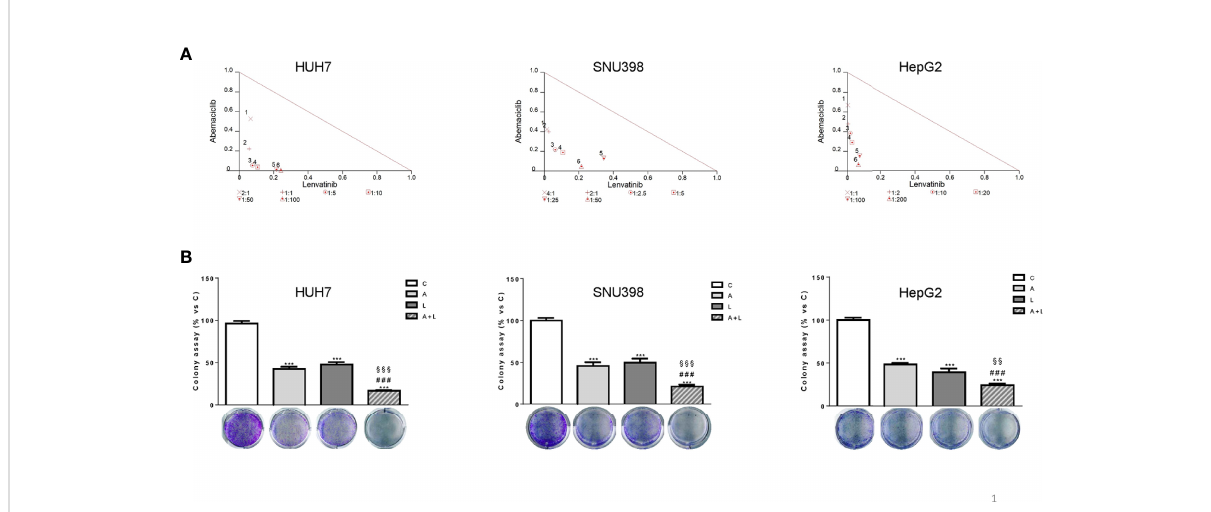
FIGURE 2 Abemaciclib and lenvatinib combination exerts additive anti-proliferative effects in HCC cells and inhibits colony formation more strongly than single agents. (A) Cells were treated with A, L or the combination. The growth medium with drugs was refreshed every 3 days. After 6 days, cell proliferation was assessed by CV assay. Combination indexes were calculated with Calcusyn software. (B) HUH7, SNU398, and HepG2 cells were treated with A or L at their corresponding IC 50 values alone or in combination. After 6 days, colony formation was assessed by CV assay. Representative images of crystal violet staining of colonies are shown. ***p<0.001 vs C, ### p<0.001 vs A; §§ p< 0.01, §§§ p<0.001 vs L. Data in A are representative of three independent experiments. Data in B are mean values ± SD of three independent